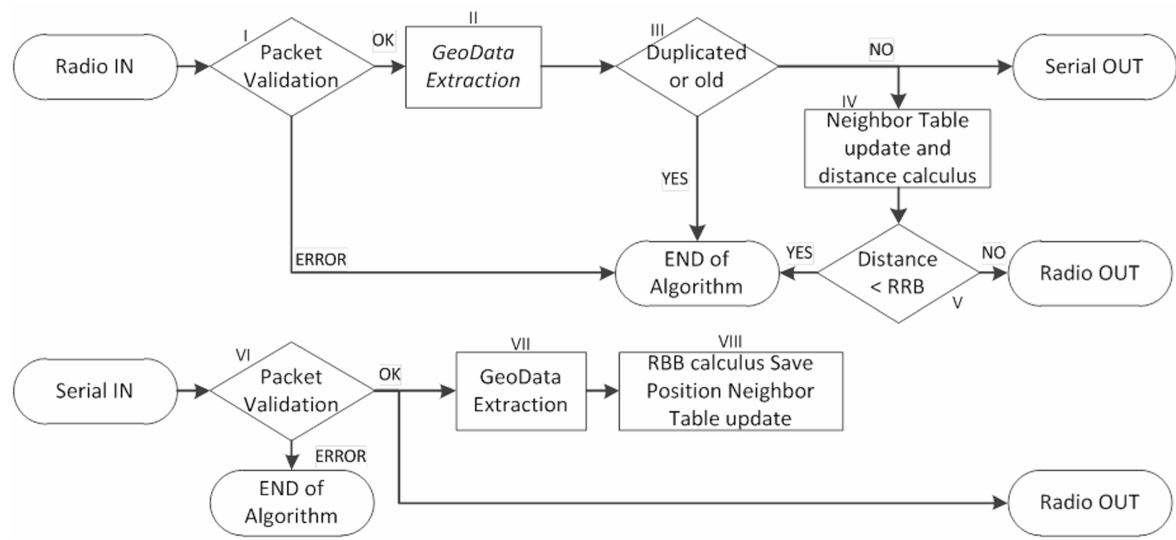
Figure 4. Flowchart of the broadcast